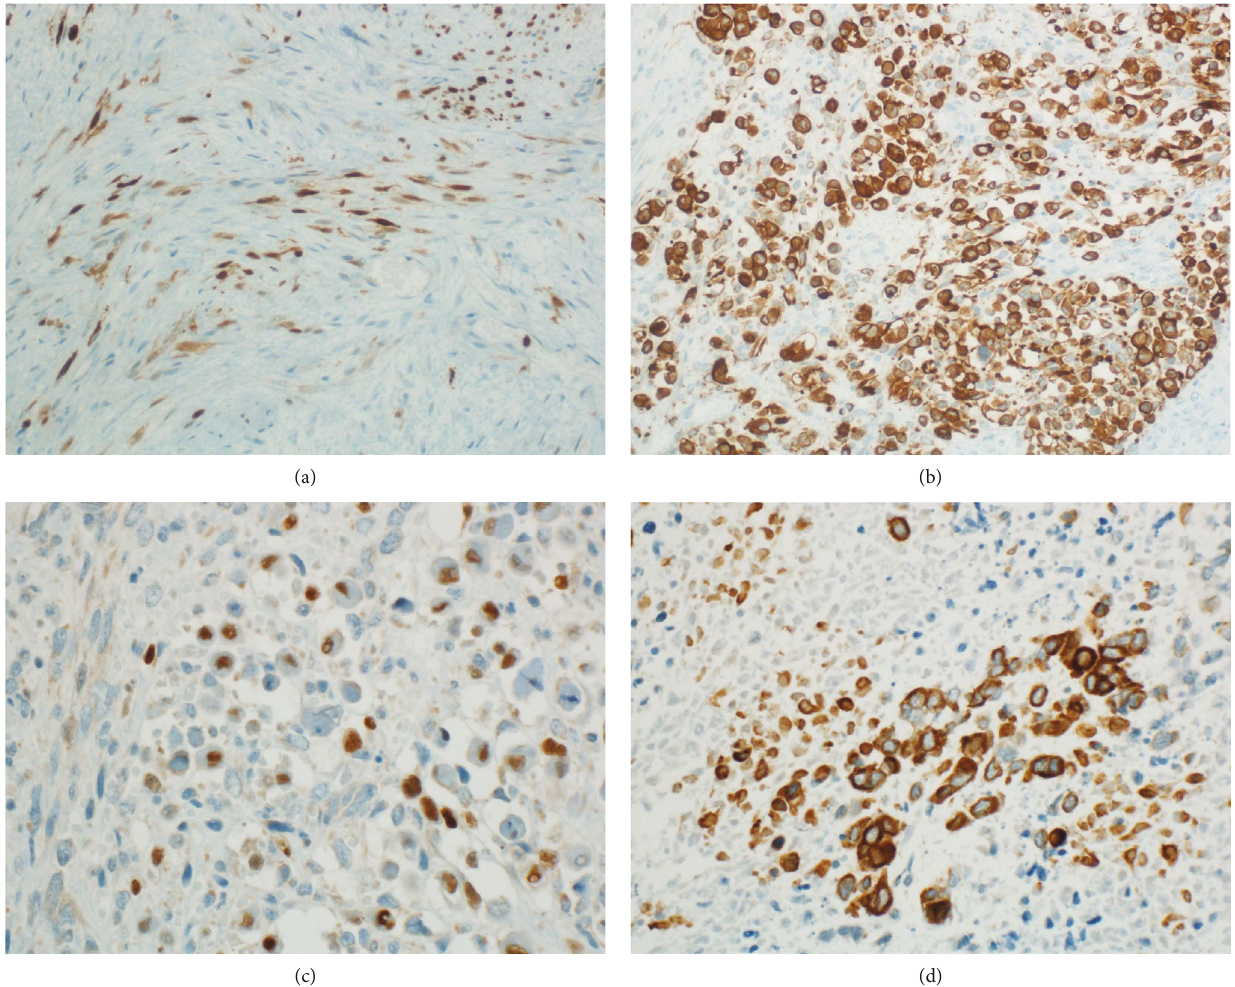
Figure 3: (a) Immunohistochemical (IHC) staining for S100 protein shows patchy nuclear and cytoplasmic expression. (b) Rhabdomyoblastic cells are strongly positive for desmin. (c) Within the foci of rhabdomyoblastic di ff erentiation, there are cells showing nuclear myogenin expression. (d) The glandular components are highlighted by pan-cytokeratin